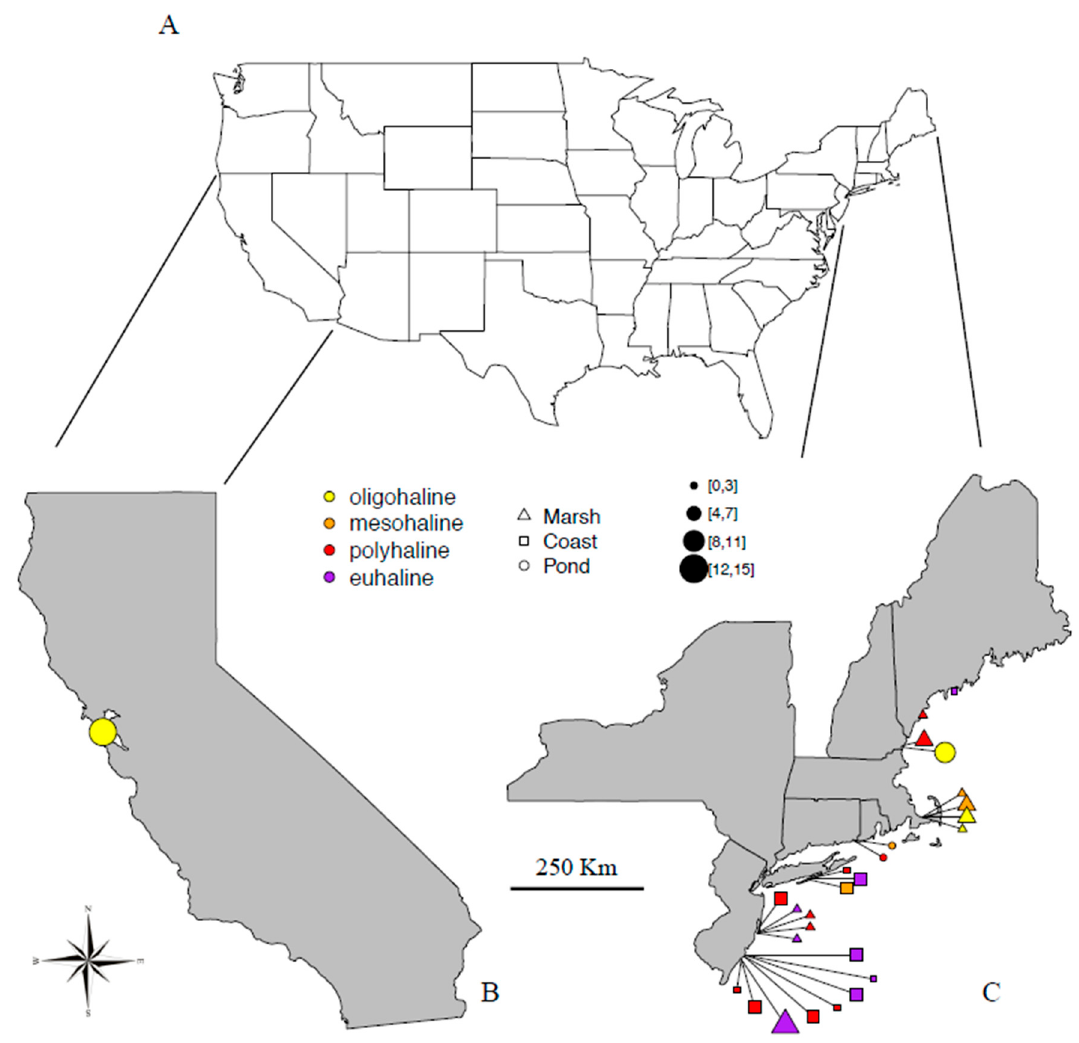
Figure 1. Map indicating sampling sites: ( A ) outline of the United States; ( B ) California. ( C ) Northeast U.S. Locations are indicated using different colors for salinities according to the Venice Classification and different shapes for the three types of ecosystem. The size summarizes the number of species found at each site.